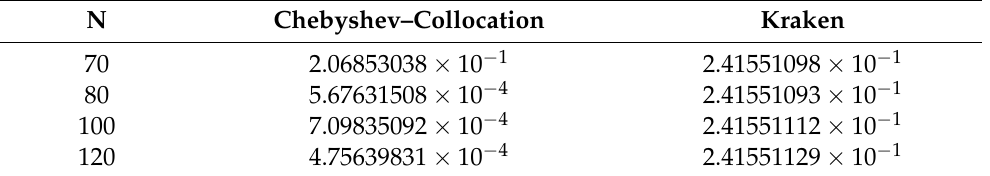
Table 5. The numerical calculation error in the entire solution domain varies with N .